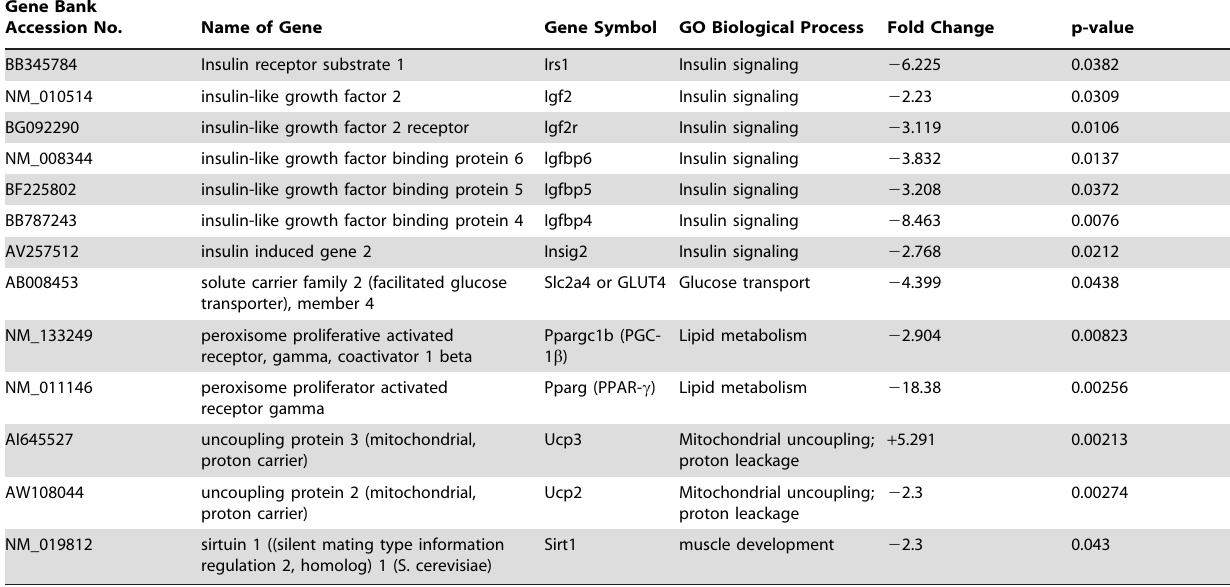
Table 3. Differential expression of key metabolic genes in skeletal muscle from 2-AA treated mice versus untreated control mice.